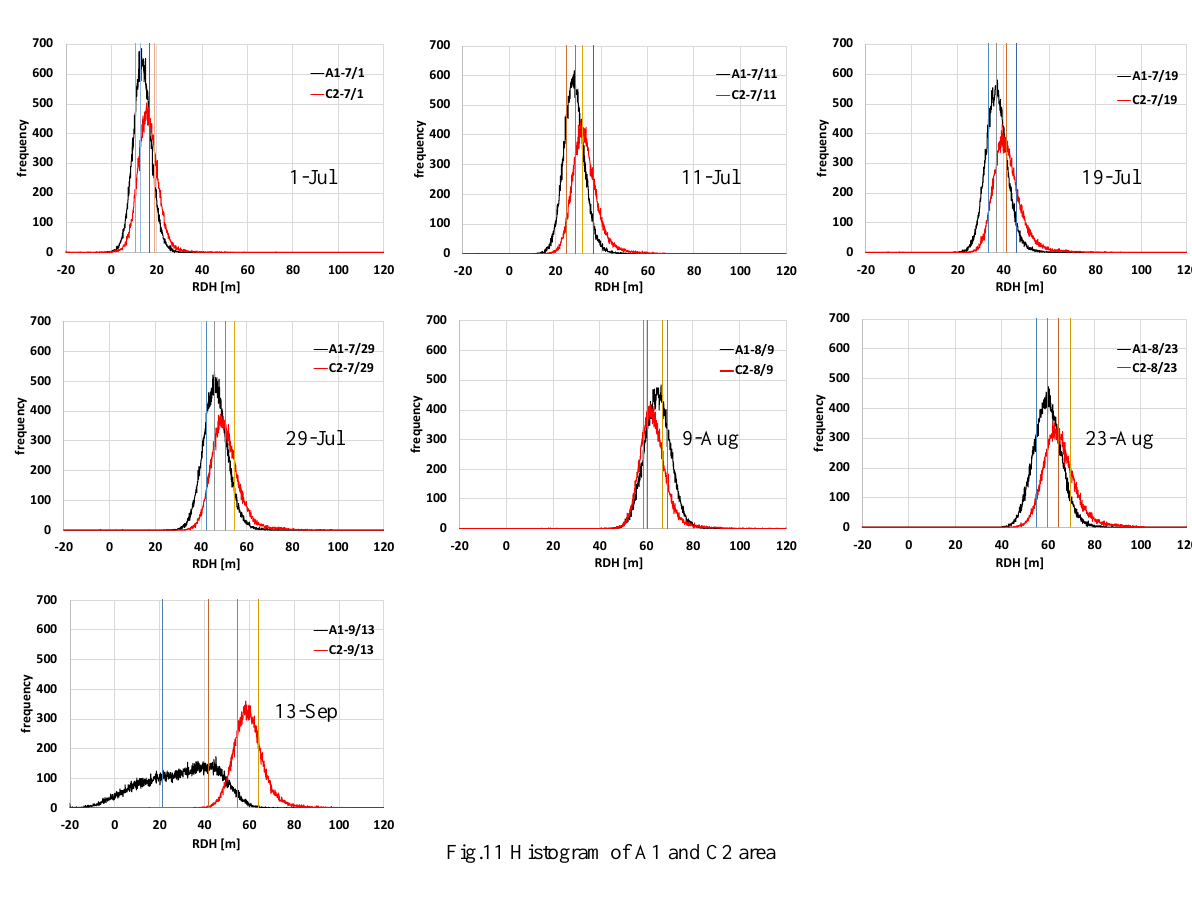
Set the threshold with ± 1σ